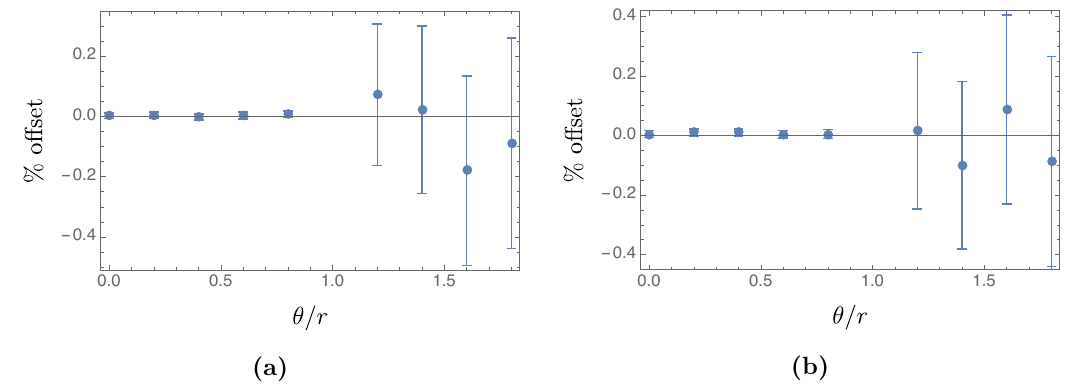
Figure 7. The o(cid:11)set between our (cid:12)nite result of the (a) gluon and (b) quark jet function and [36] for several values of (cid:18) r